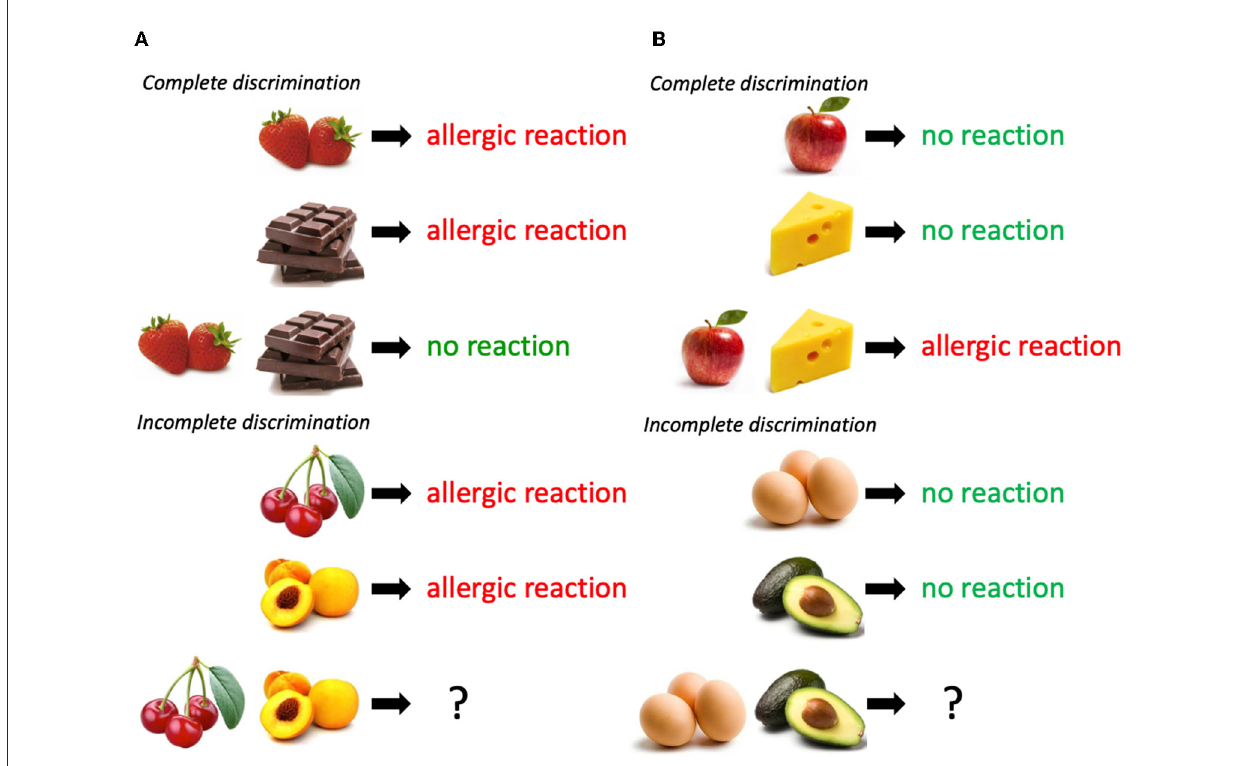
FIGURE2 Schematic examples of some of the trial types used in the Shanks and Darby (1998) task. (A) depicts a negative patterning discrimination. (B) depicts a positive patterning discrimination. Each combination of food(s) and allergic reaction outcome constitutes one trial type that would be repeated several times across the course of a lengthy learning phase. Participants learn several “complete discrimination” examples of food-outcome contingencies that follow two variants (positive and negative) of a simple patterning rule. They also learn food-outcome contingencies which may or may not follow the same rule (incomplete discriminations). Participants are asked to use all the knowledge they have learned in the task to predict what will happen for the transfer items that involve combinations which they have not observed (bottom row)